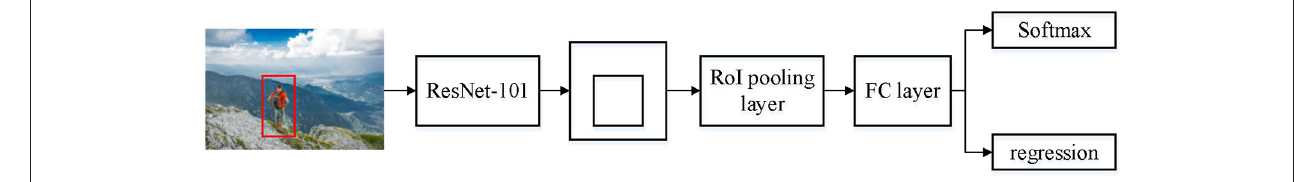
FIGURE 2 | Improved RoI pooling